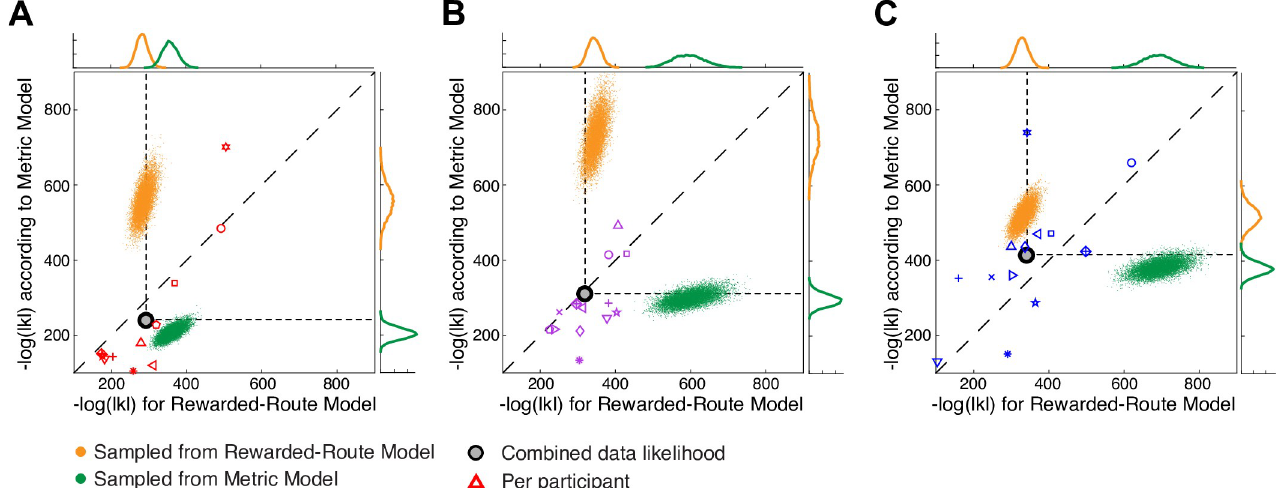
Fig 12. Comparing models by sampling. Panels A, B and C show data and models for the Fixed, one-wormhole and three-wormhole conditions respectively. As in Fig 10B, negative log likelihood under the shortest-distance model is plotted against negative log likelihood under the rewarded-choice model. The grey dot in each panel shows, for each condition, the likelihood of the data for all participants in both Layouts and all repeats under both models (with α and β parameters fitted individually per participant). Orange and green clouds indicate 10000 synthetic data-samples generated from the rewarded-choice and shortest-distance models respectively. (likelihoods sampled from individual participant models and then combined). The negative log likelihood of the actual combined data is indicated by the grey circle and is the same as shown in Fig 10A. Open symbols indicate individual participants, where corresponding likelihoods were scaled by raising each to the power n = 14 (number of